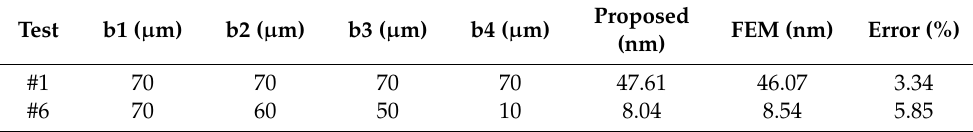
Table 7. Tip displacement when the second layer is SiO 2 and the substrate